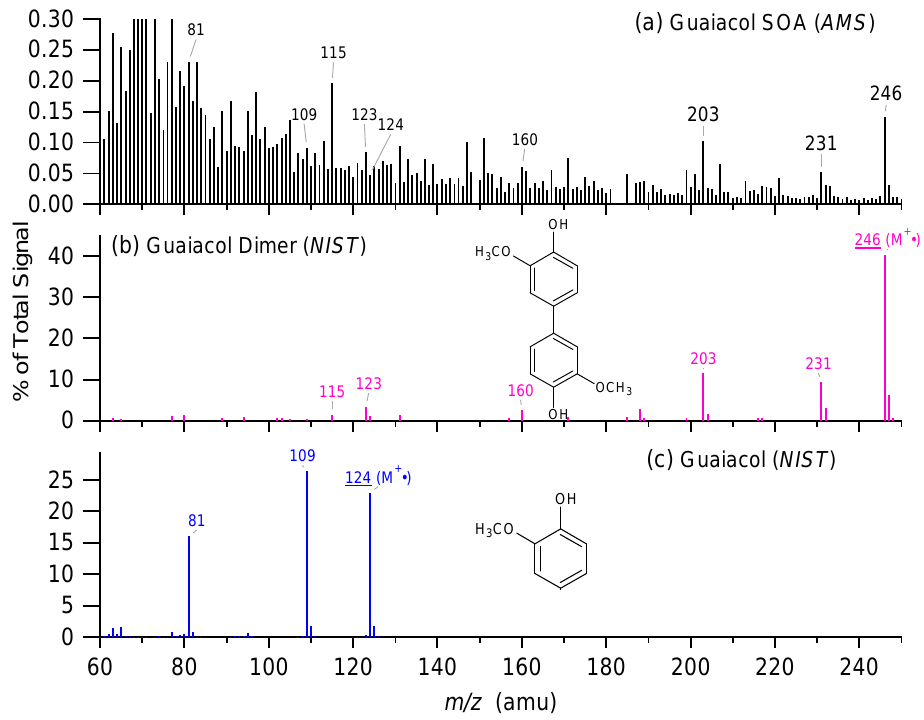
Fig. 6. Comparisons of (a) the AMS mass spectrum (in integer m/z) of guaiacol SOA formed via aqueous-phase photoreactions (w/ OH, pH=5) with (b) the NIST mass spectrum of the C-C coupled dimer of guaiacol and (c) the NIST mass spectrum of guaiacol. The molecular ions (M + ) are marked and the molecular structures of guaiacol and the guaiacol C-C dimer are shown.